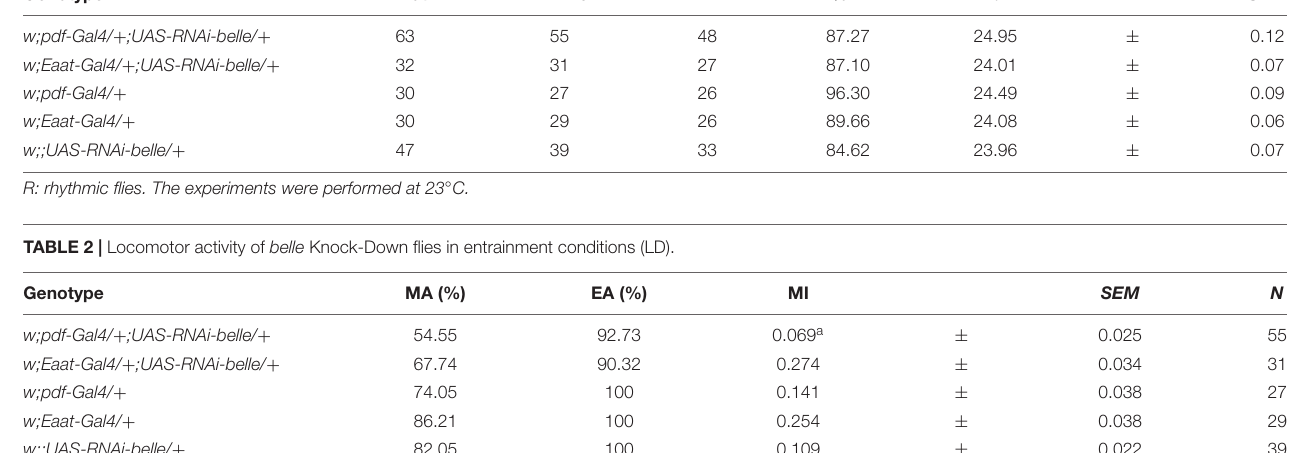
FIGURE 4 | belle mRNA expression shows circadian features. qRT-PCR on heads from white 1118 and per 0 flies reared in 12.12 LD (A) or over the third day in DD (B) . Relative abundance of belle mRNA was defined as a ratio with rp49 . Values represent mean levels ± SEM of three biological replicates. The value corresponding to CT 54 in per 0 flies represents mean level of two biological replicates. TABLE 1 | Locomotor activity of belle Knock-Down flies under constant darkness (DD). Genotype